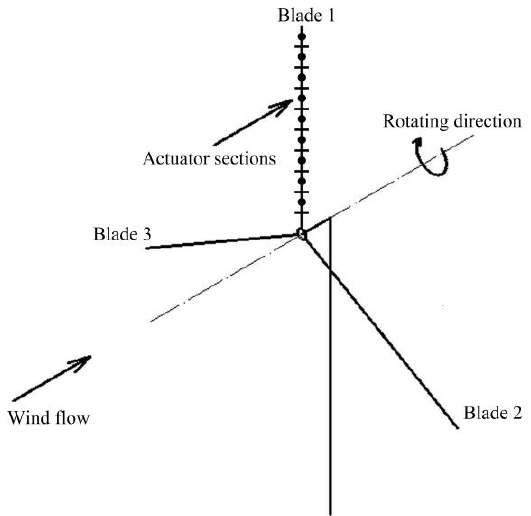
Figure 1. Blades represented by actuator line and discretized into actuator sections.